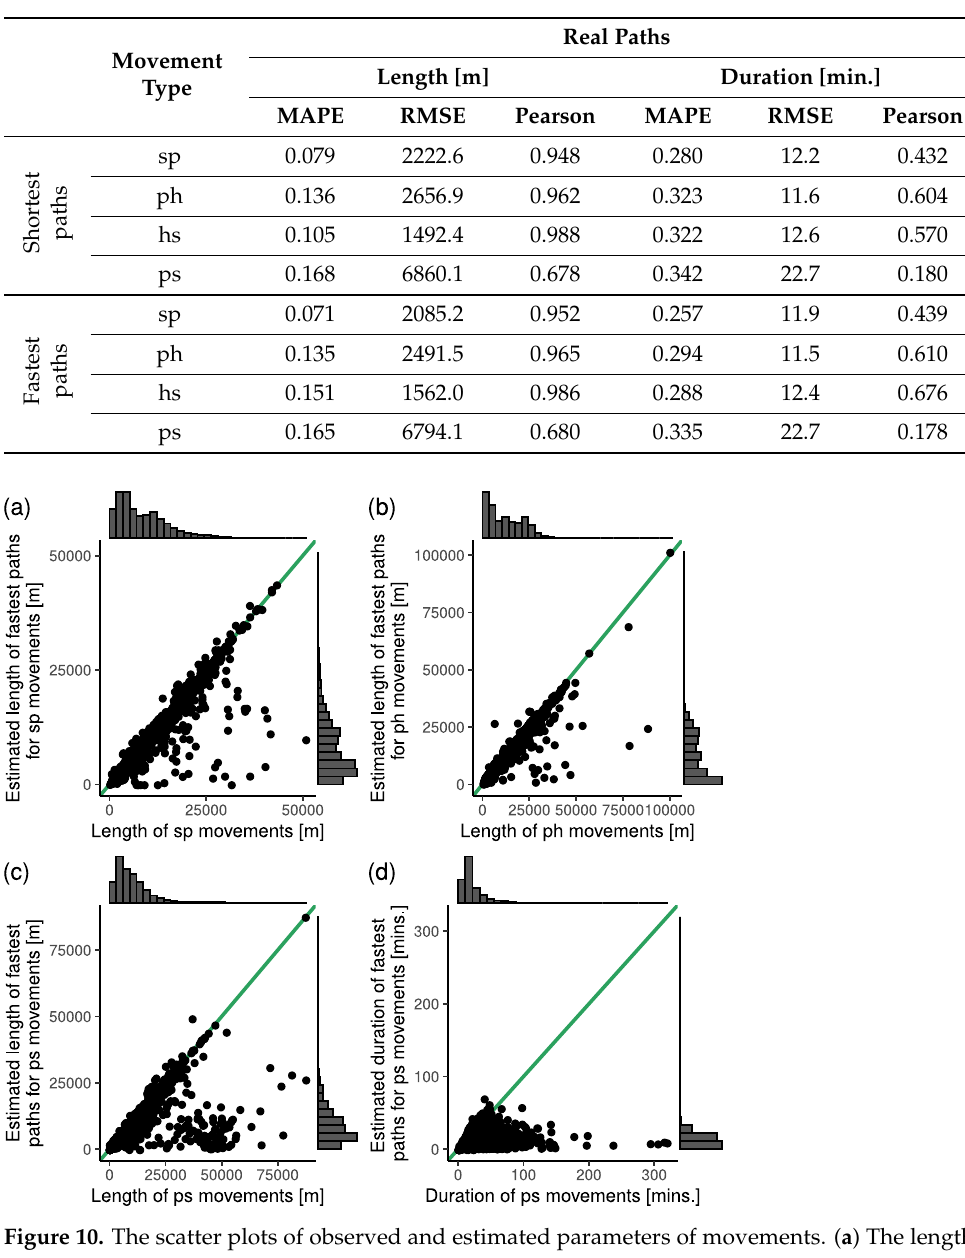
Table 2. An evaluation of the agreement between the lengths and durations of real movements and the shortest and the fastest paths connecting the same origins and destinations.